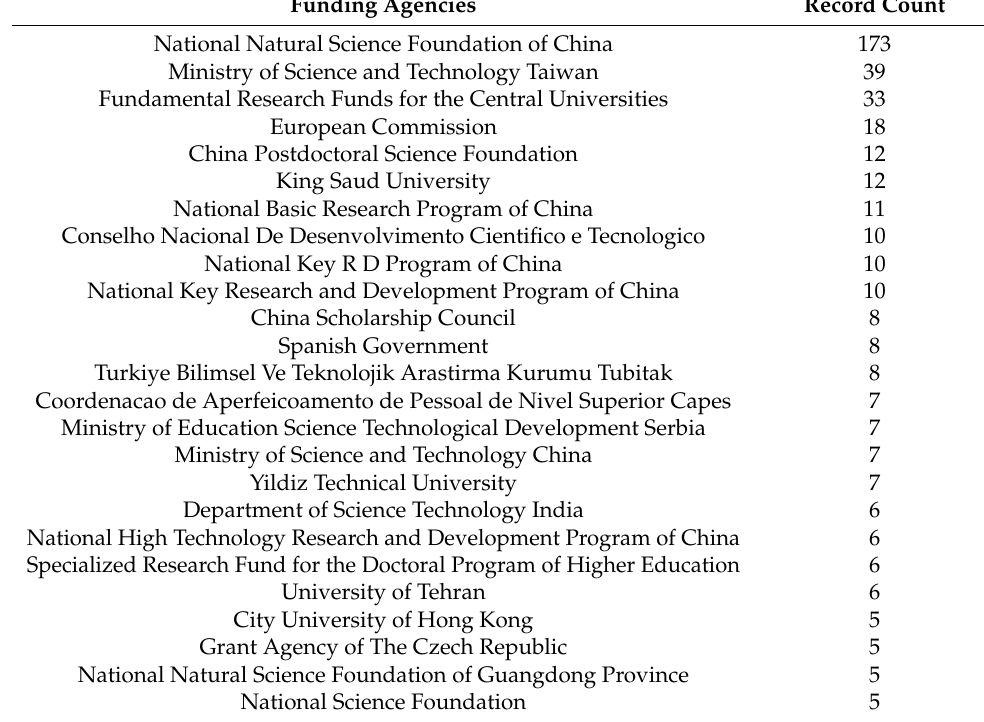
Table 2. Top 25 Funding